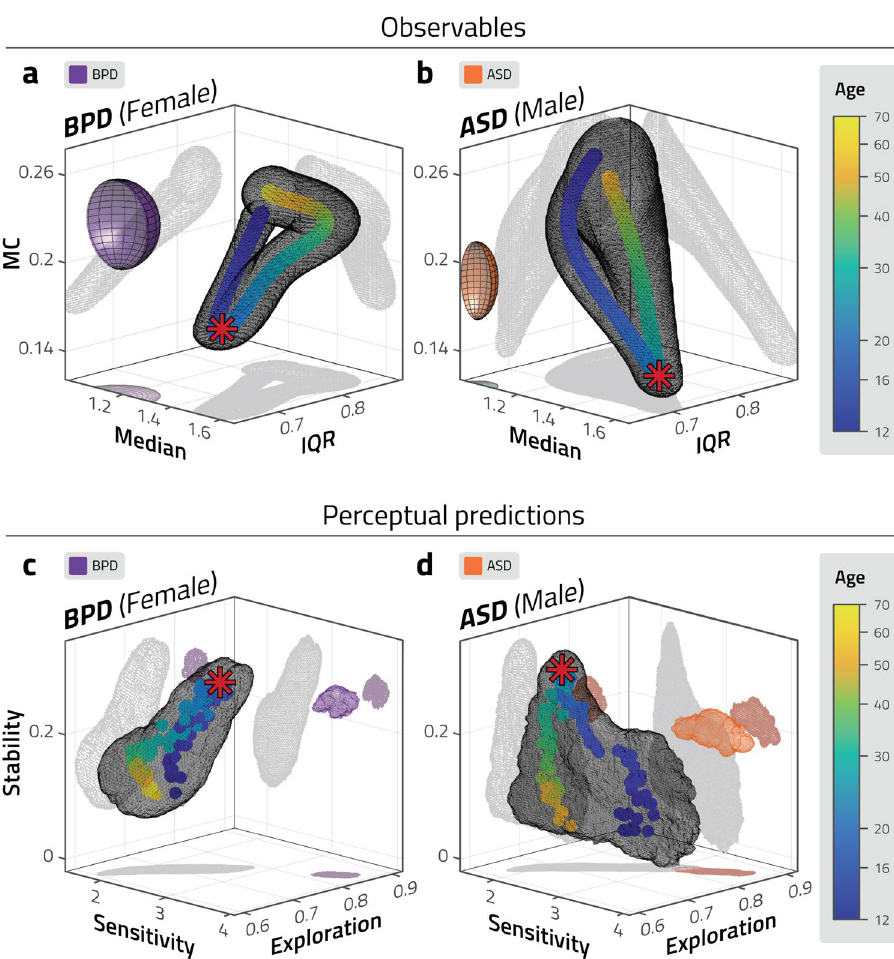
Figure 5. Observed distribution parameters and predicted perceptual behaviour of atypical groups. Observed distribution parameters ( a , b ), and predicted perceptual behaviour in volatile environments ( c , d ) for atypical groups, compared to neurotypical trajectories. Observers with borderline personality disorder (BPD, all female) are compared to neurotypical females of different ages. Observers with autism spectrum disorder (ASD, all male) are compared to neurotypical males of different ages. ( a , b ) Ellipsoids represent mean SEM values for BPD (purple) and for ASD (in orange). ( c , d ) Coloured volumes represent confidence intervals (standard deviation) for BPD (purple) and for ASD (in orange). The dominance period statistics and perceptual predictions of both groups fall outside the typical developmental and maturational